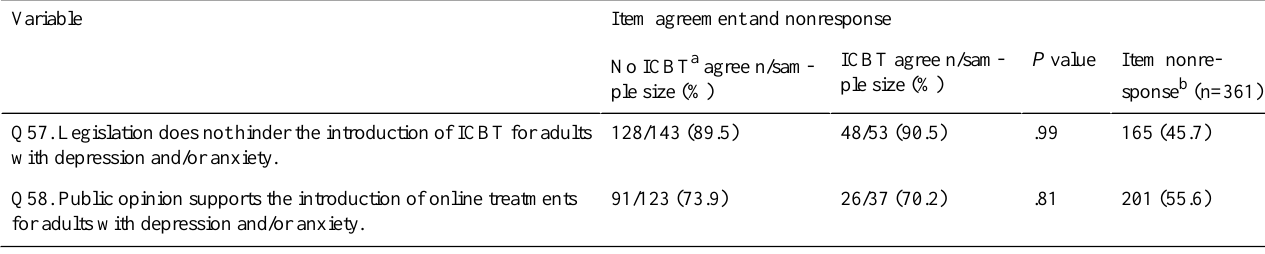
Item agreement and nonresponseVariable